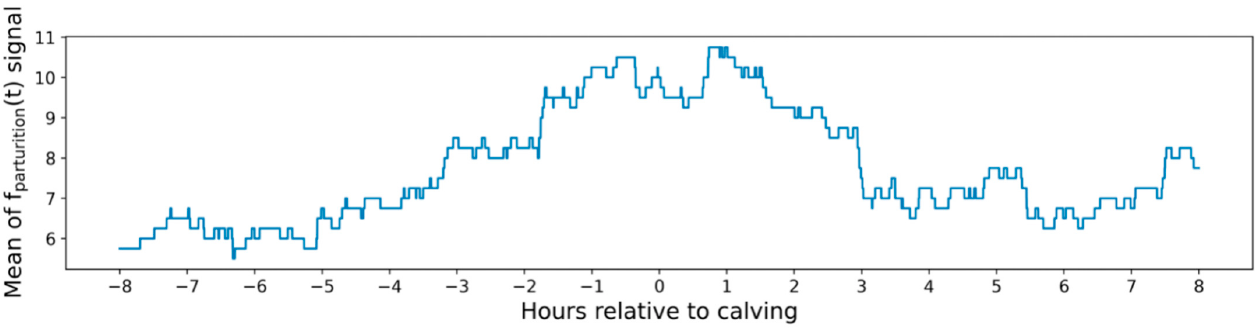
Figure 9. Mean of lying bouts (function f parturition ( t ) ) from the five cows which parturitions are indicated in Table